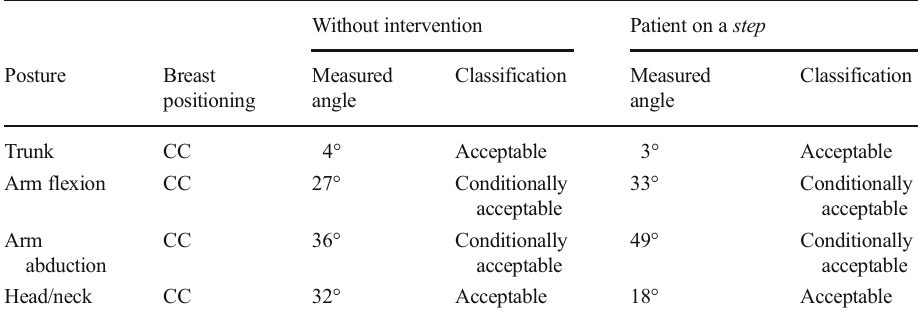
Table 7 Angles measured on the radiographer performing CC breast positioning (radiographer taller than the